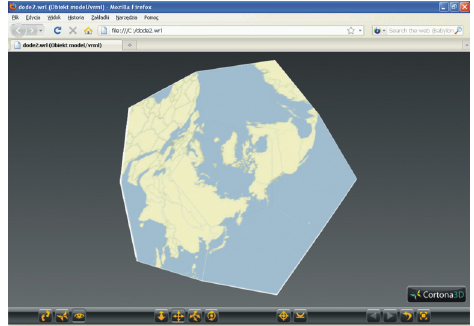
Fig. 29. Virtual dodecahedron with a map of the World